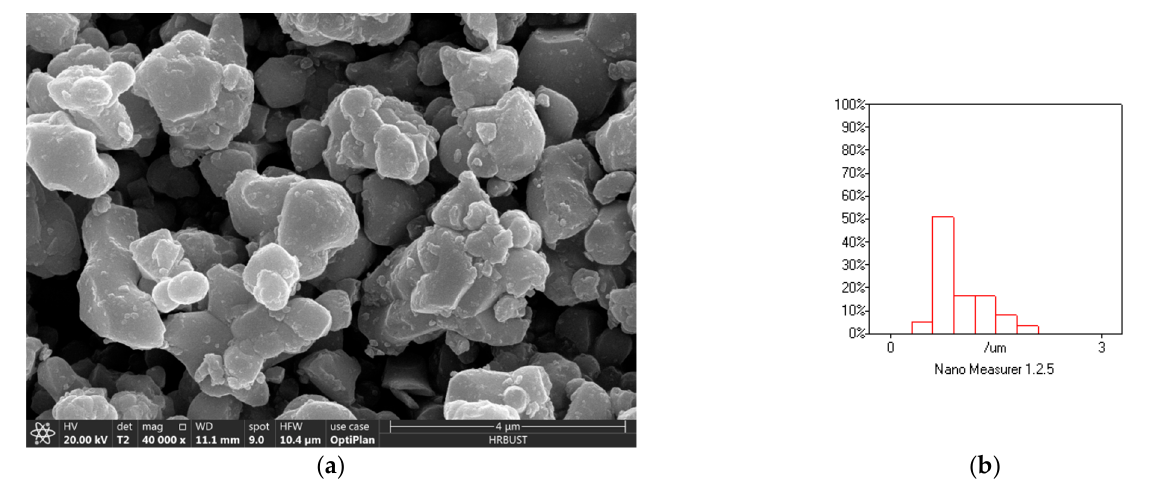
Figure 3. ( a ) Particle morphology of CCTO; ( b ) particle size distribution of CCTO.